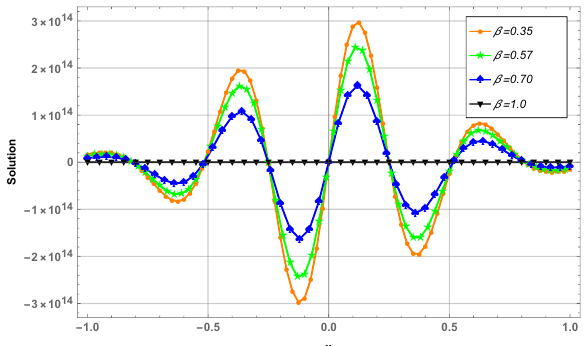
Figure 6. 2D surface formation at different values of β in Example 1 when k = 1, t = 3. For the time-fractional Ito equation in Example 2, Table 5 is the comparison of LHPM with the modified Adomian decomposition method (mADM) and FCRPSA error at β = 1 and k = 0.01, whereas Table 6 displays the residual errors at different values of β . In both tables, it can be seen that LHPM is a reliable and powerful technique. Figure 7 is the LHPM solution and error graphs in 3D form, which displays the decrease in wave altitude with the increase of distance and time. The effect of different values of fractional parameter on the water waves surface at distance x = 10 can be seen in Figure 8, which shows that increasing β decreases the water wave level for the interval 0 < t < 1. A 2D plot to evaluate the motion of the wave surface is displayed in Figure 9 for k = 1, t = 3, and β = 0.2, 0.4, 0.8, and 1.0. It can be seen that nearby x = 0, the wave is at its peak but starts declining as the distance becomes